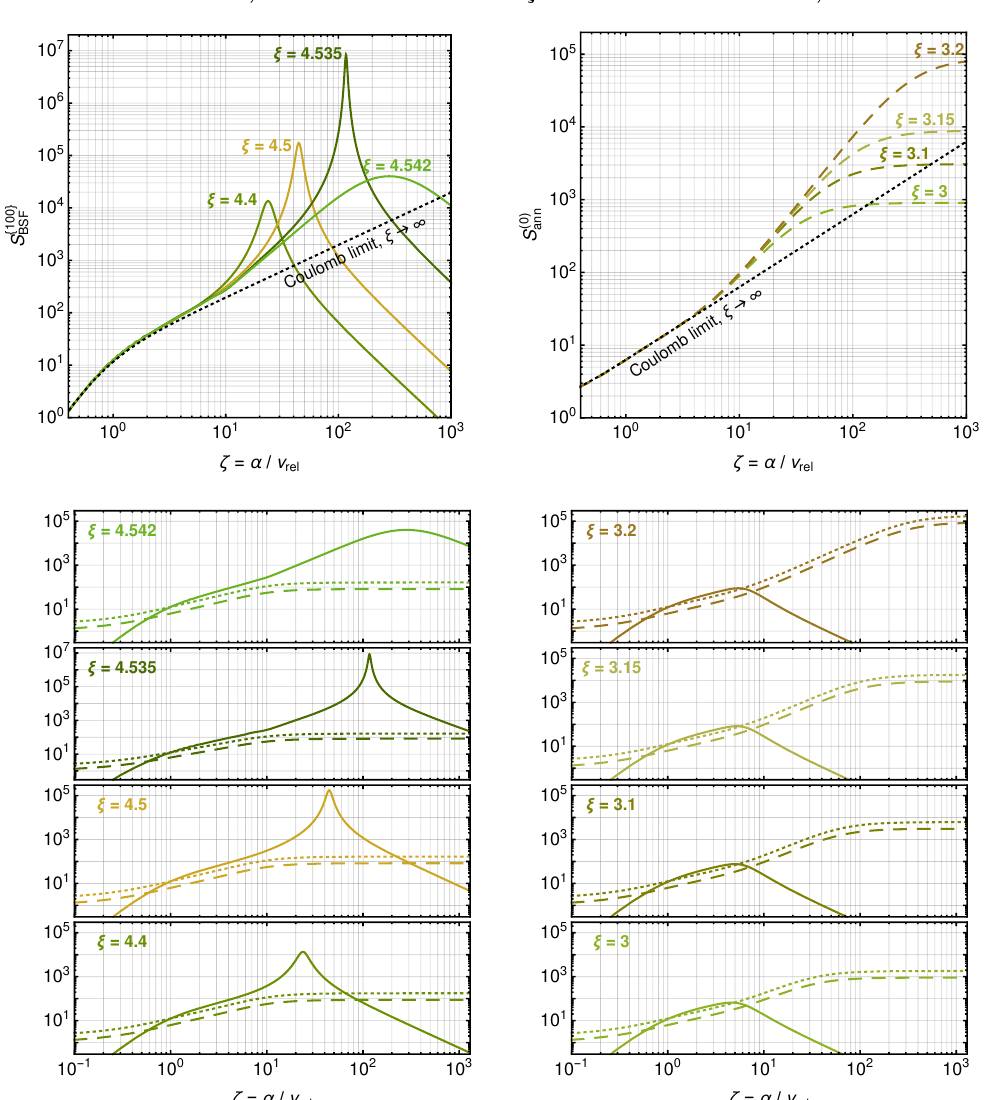
Figure 3c . Velocity dependence of S f 100 g